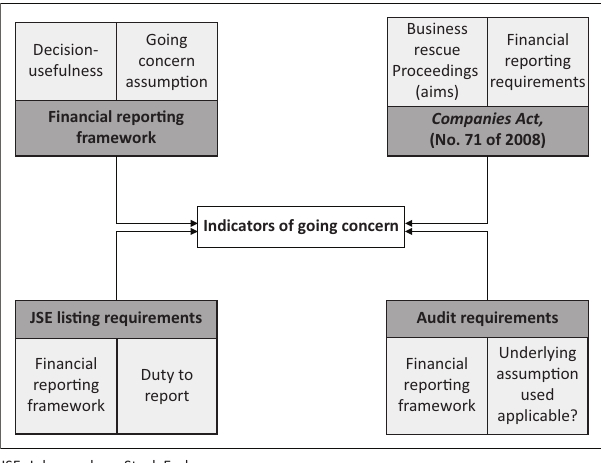
FIGURE 1: Going concern assessment in the context of a listed company under business